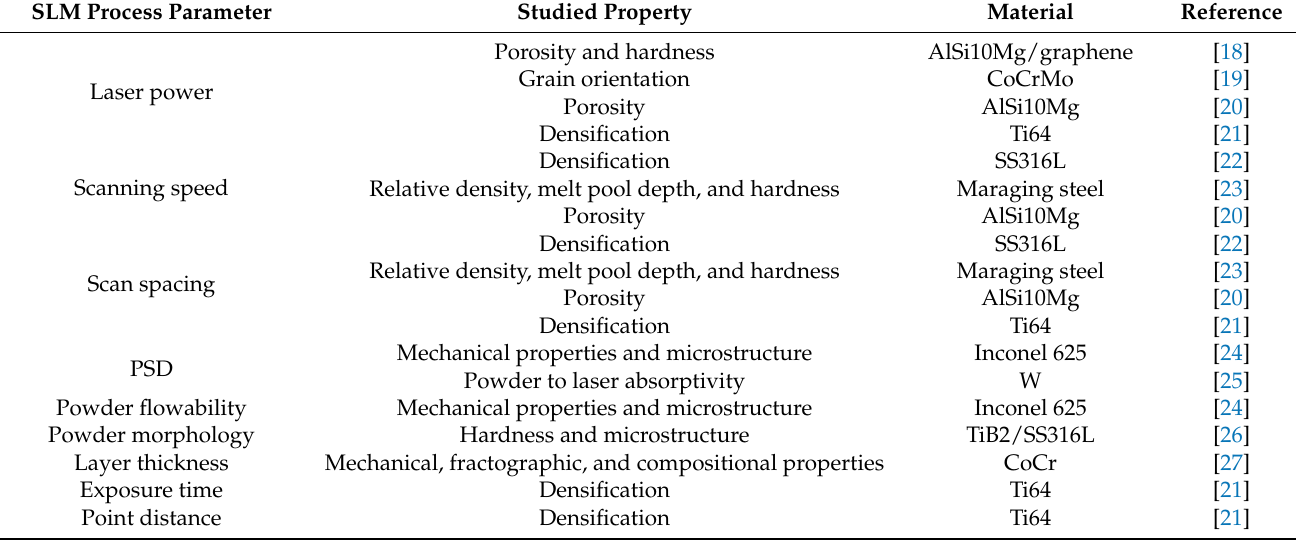
Table 1. Experimental investigations on the effect of relevant process parameters in SLM.